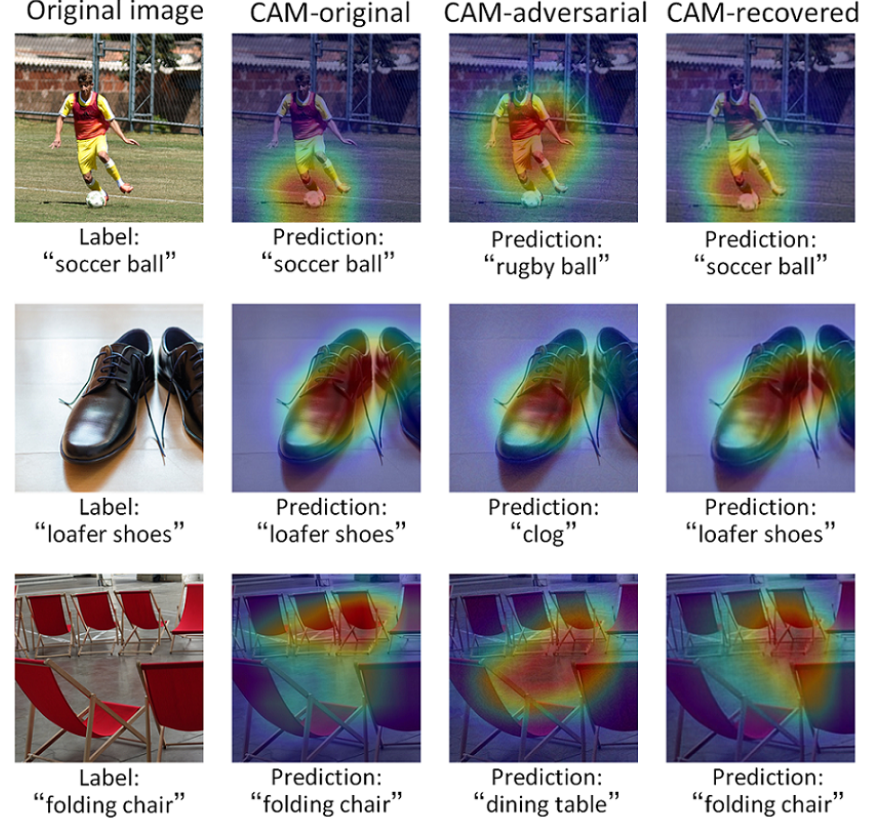
Figure 8. Class activation maps for original, adversarial and recovered